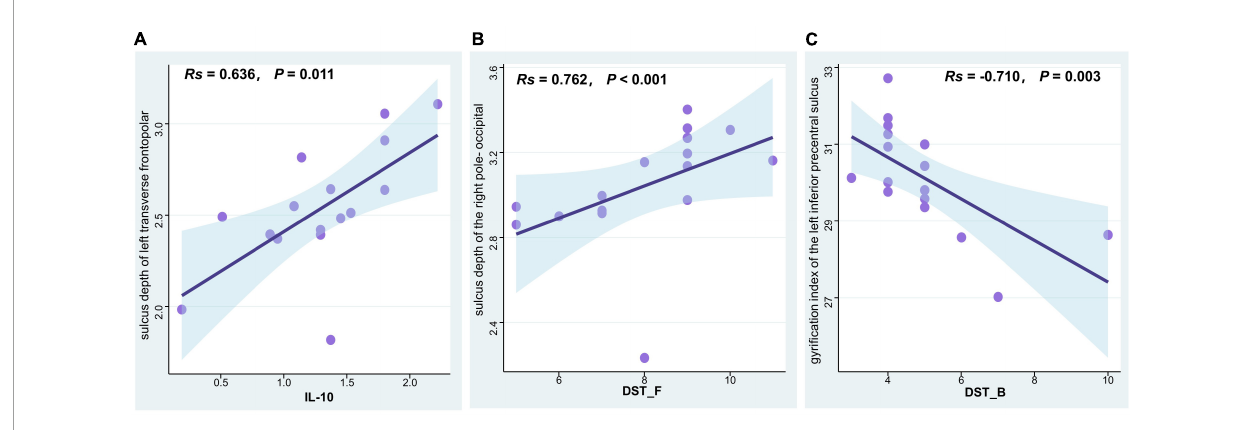
FIGURE3 Correlation analysis of SBM indices, cytokine levels, and cognitive function scores in T2DM patients with normal cognitive function. (A) IL-10 levels were positively associated with the sulcus depth of left transverse frontopolar gyri and sulci (Spearman correlation, R = 0.636, P = 0.011). (B) The digit span test-forward scores were positively associated with the sulcus depth of the right pole-occipital (Spearman correlation, R = 0.762, P < 0.001). (C) The digit span test-backward scores were negatively associated with the gyrification index of the left inferior part of the precentral sulcus (Spearman correlation, R = –0.710, P = 0.003). T2DM, type 2 diabetes mellitus group; SBM, surface-based morphometry; IL-10, interleukin 10; DST_F, digit span test-forward; DST_B, digit span